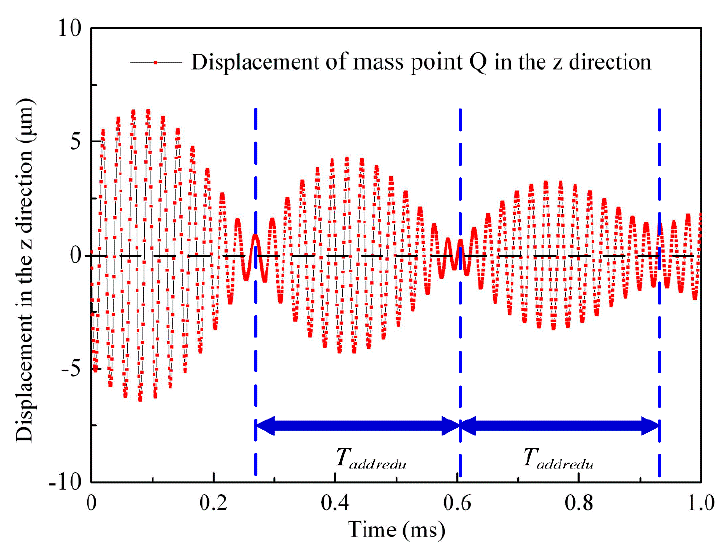
Figure 13. Displacement variation curve of the vertical direction.